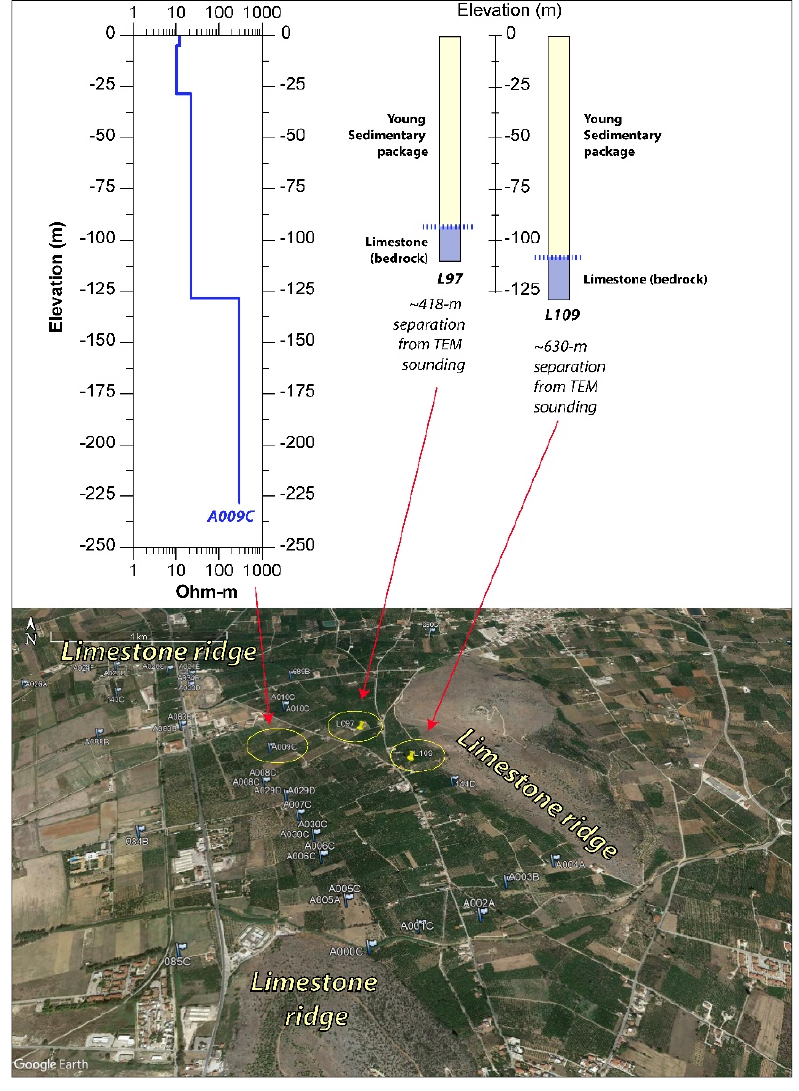
Figure 6. Example of 1D inversion of the TEM data (solid blue line) with nearby vintage vertical stratigraphic logs. The stratigraphic logs L97 and L109 reach bedrock at 97 m and 109 m, respectively, and are located ~418 m and ~630 m eastward from TEM station A009C on profile P4 (also shown in Figure 7). The stratigraphic logs suggest that the resistivity structure of a young sedimentary cover deposited over a weathered and fractured bedrock should yield a low to high resistivity pattern, where the low-resistivities correspond to the clastic sequence over a high-resistivity half-space (bedrock). The TEM soundings support this resistivity